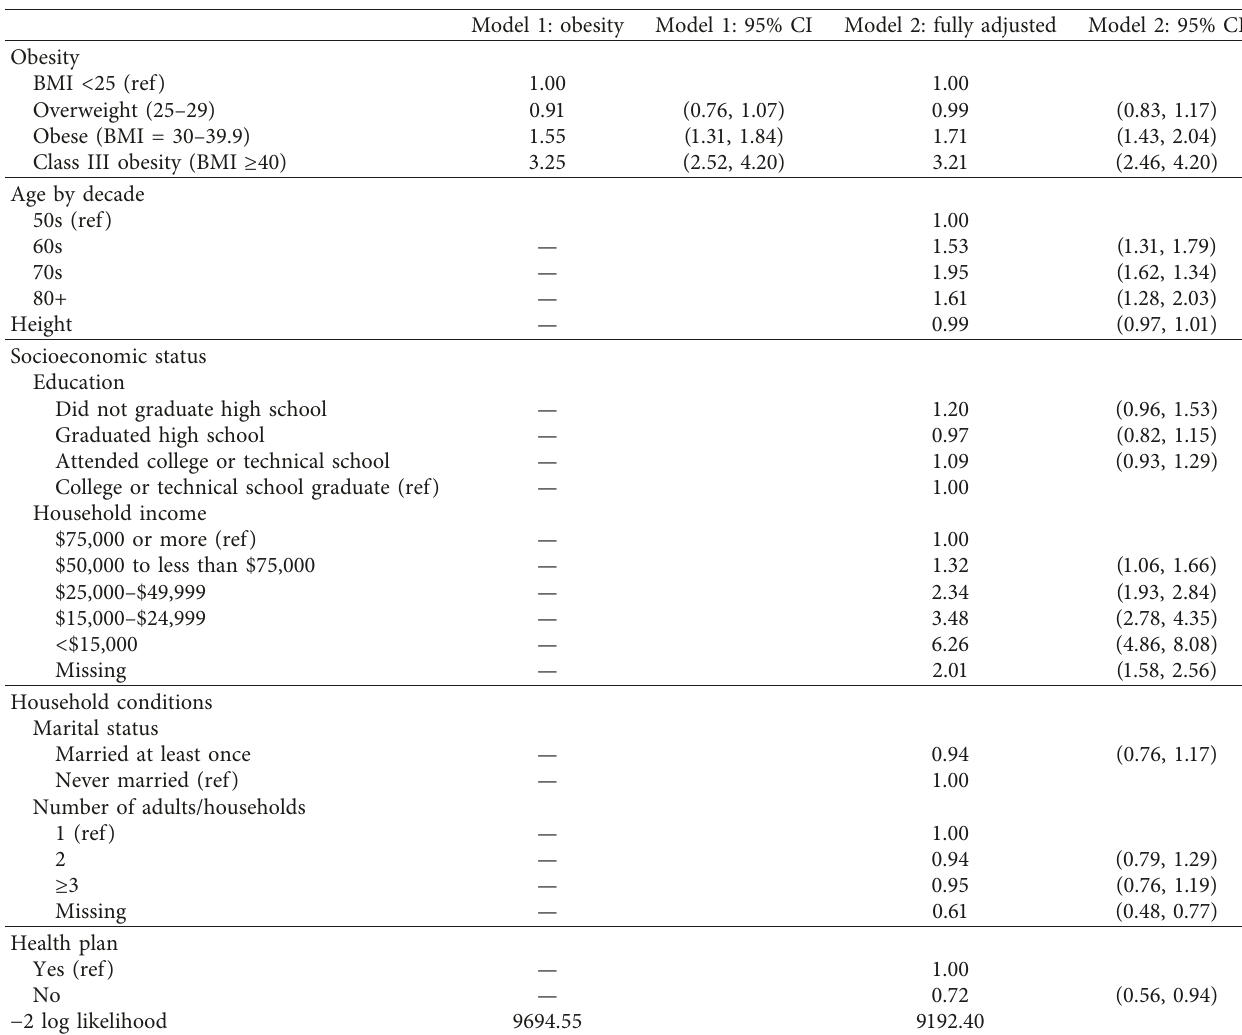
Table 4: Logistic regression analyses of COPD among non-Hispanic white older men (aged 50+) who had never smoked ( n � 37 , 618) (odds ratios and 95% confidence intervals